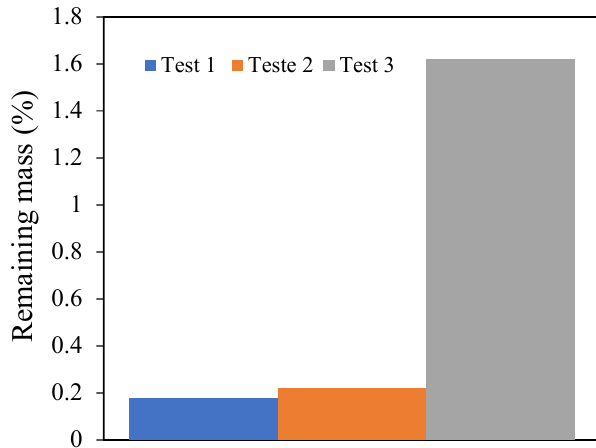
Figure 5. The remaining mass of the three tests in the same condition with the middle particle size.